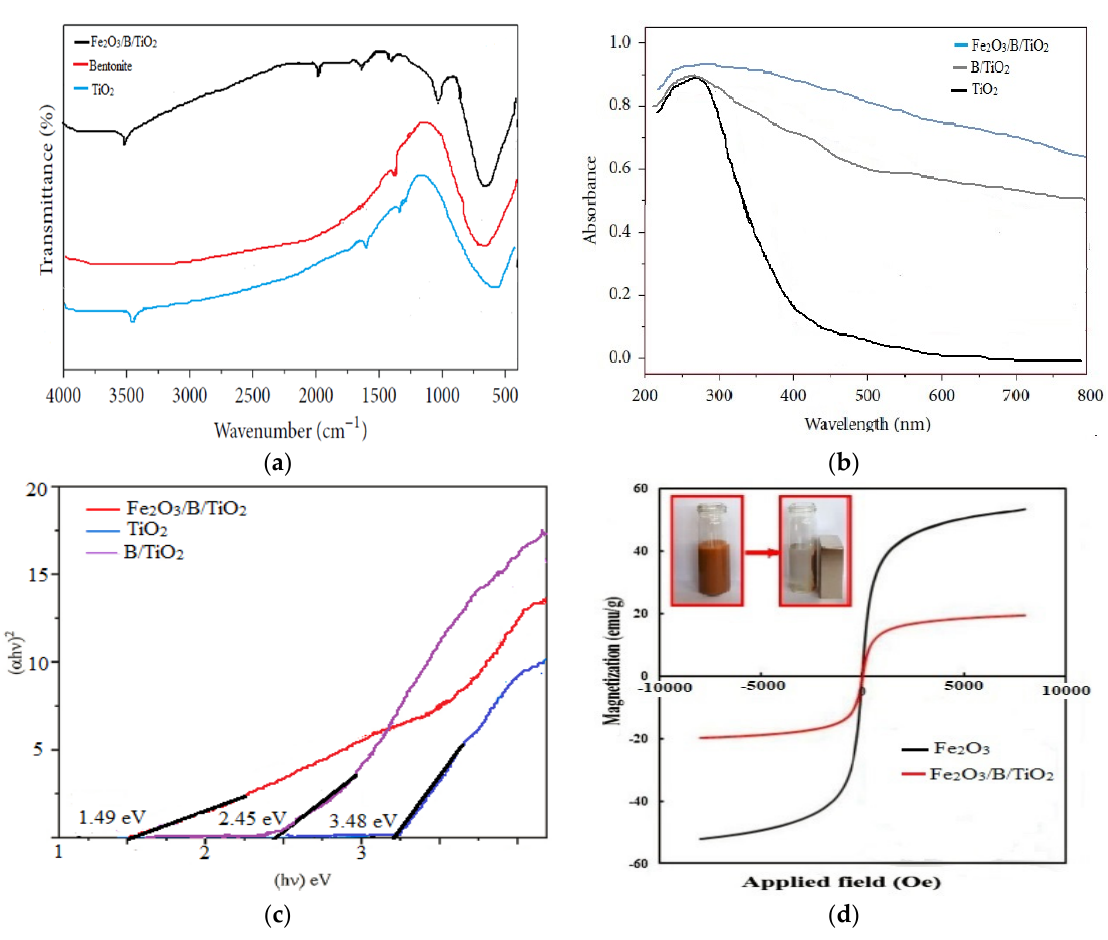
Figure 1. FTIR spectra of bentonite, TiO 2, and Fe 2 O 3 /B/TiO 2 ( a ), Diffuse reflectance UV–Vis spectra ( b ), Tauc plot derived from the Kubelka Munk Function for band gap energy ( c ), Magnetic hysteresis curves ( d ).